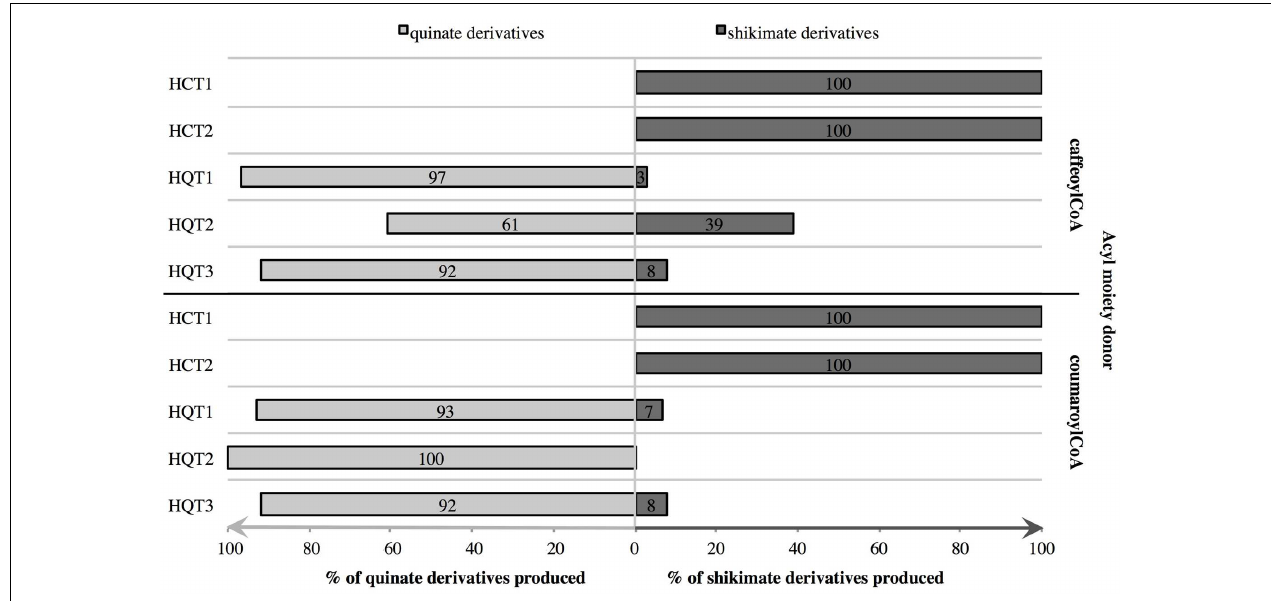
FIGURE 7 | Competition assays to determine the preferred acyl acceptor of HCTs and HQTs. Recombinant proteins were incubated with caffeoyl-CoA or p -coumaroyl-CoA and both quinic and shikimic acids at the same concentrations. After 1 h, products of the reactions were quantified in µ mol and the relative concentrations of each product calculated (% of total products). Values are means of three independent replicates.